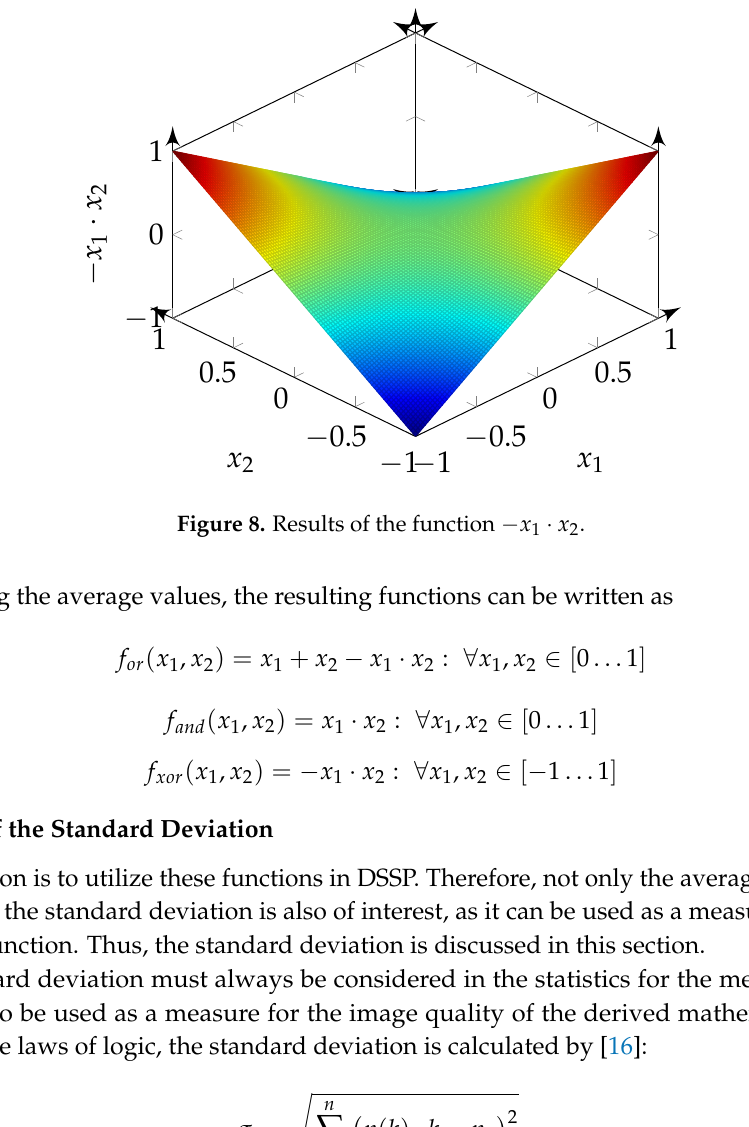
Figure 8. Results of the function